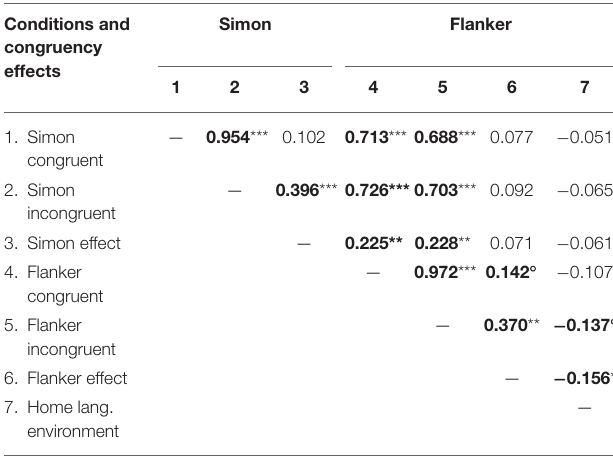
TABLE 3 | Pearson correlations between performance in task conditions and measures of inhibitory control. Conditions and